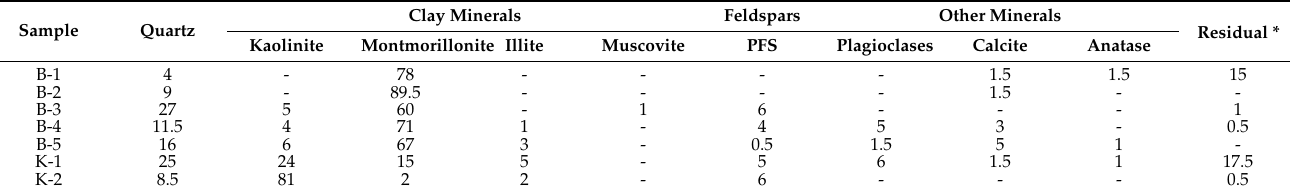
Table 3. Mineral composition of the clay materials.